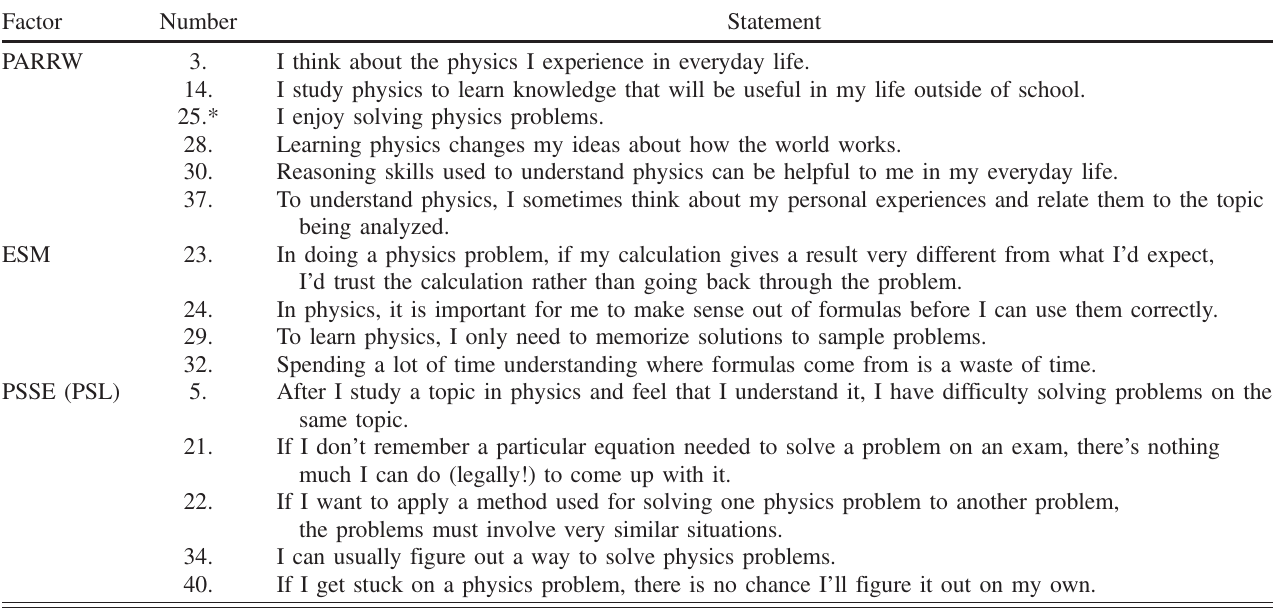
TABLE I. The CLASS statements for the three factors: personal application and relation to real world, problem solving self efficacy (formerly called problem solving and learning), and effort and sense making according to Ref. [11]. Statement 25, marked with an asterisk, also loads on